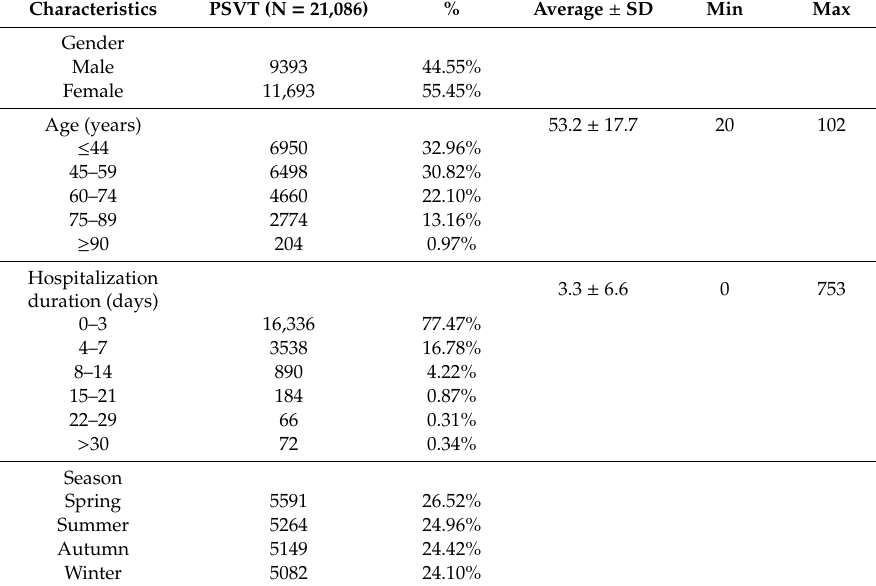
Table 1. Characteristics of 21,086 patients residing in Taiwan diagnosed with PSVT from 2001 to